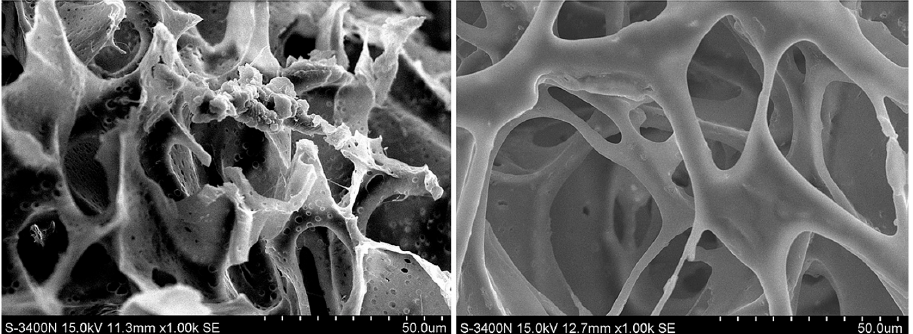
Figure 22. SEM micrographs of PNIPAAm/SWCNT (on left ) and PNIPAAm hydrogel (on right ). Reprinted with permission from reference [43]. Copyright from © 2014 Elsevier Ltd. (Amsterdam, The Netherlands).